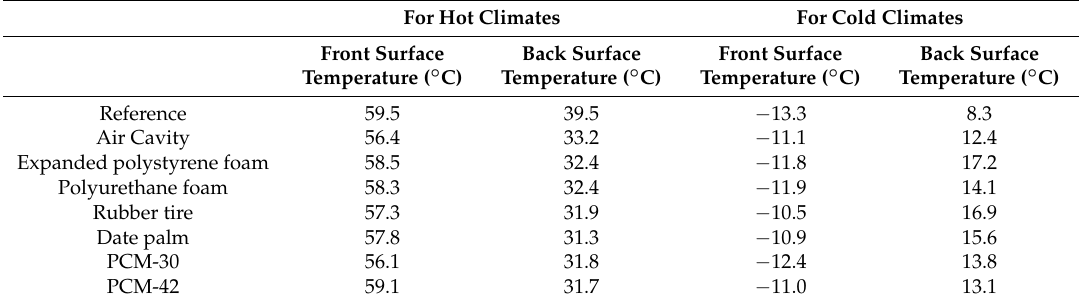
Table 2. Summary of steady-state temperatures for all material in hot and cold climatic conditions.